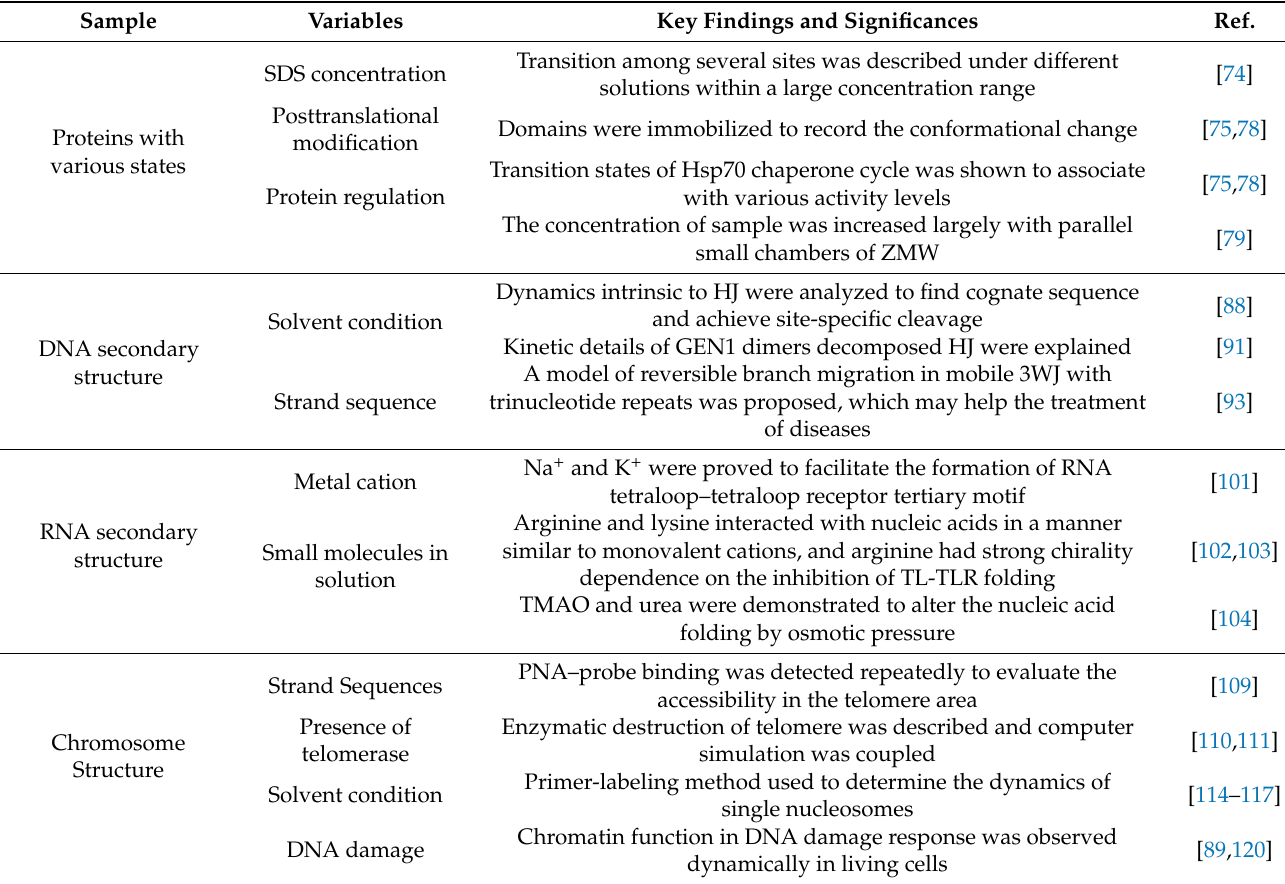
Table 1. Representative smFRET studies on the structural change of biomolecules.